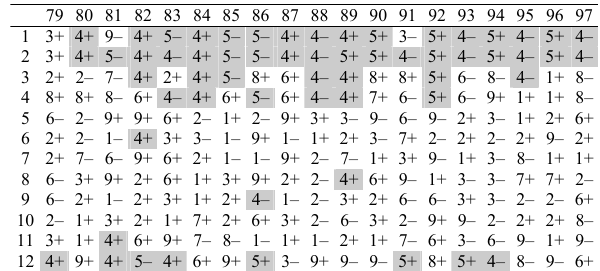
Table 7. As in Table 6 but for